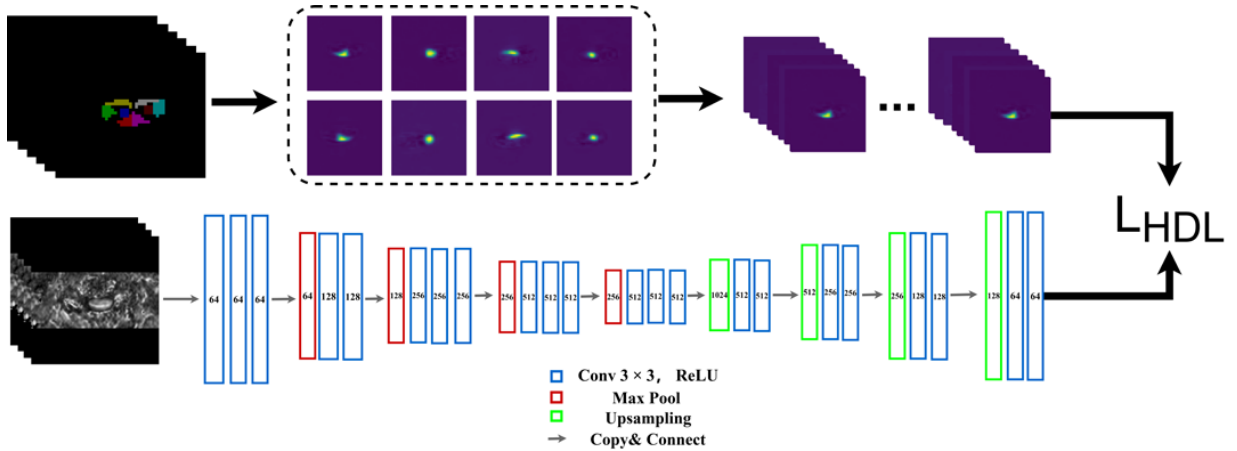
Figure 2. Structure of the segmentation network.